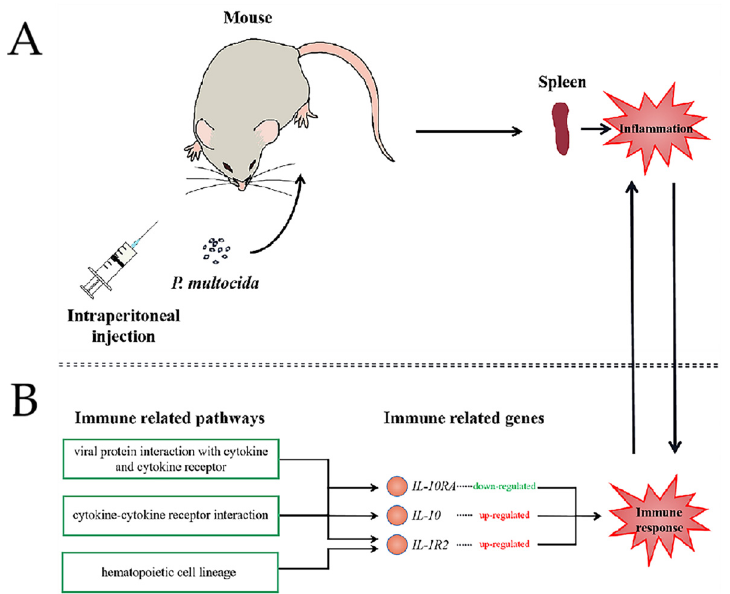
Figure 11. Schematic diagram of body changes caused by P. multocida infection in mouse spleen. ( A ) Mouse spleen model of P. multocida infection. ( B ) Part of the known relationship between interleukin-family-related pathways and genes.